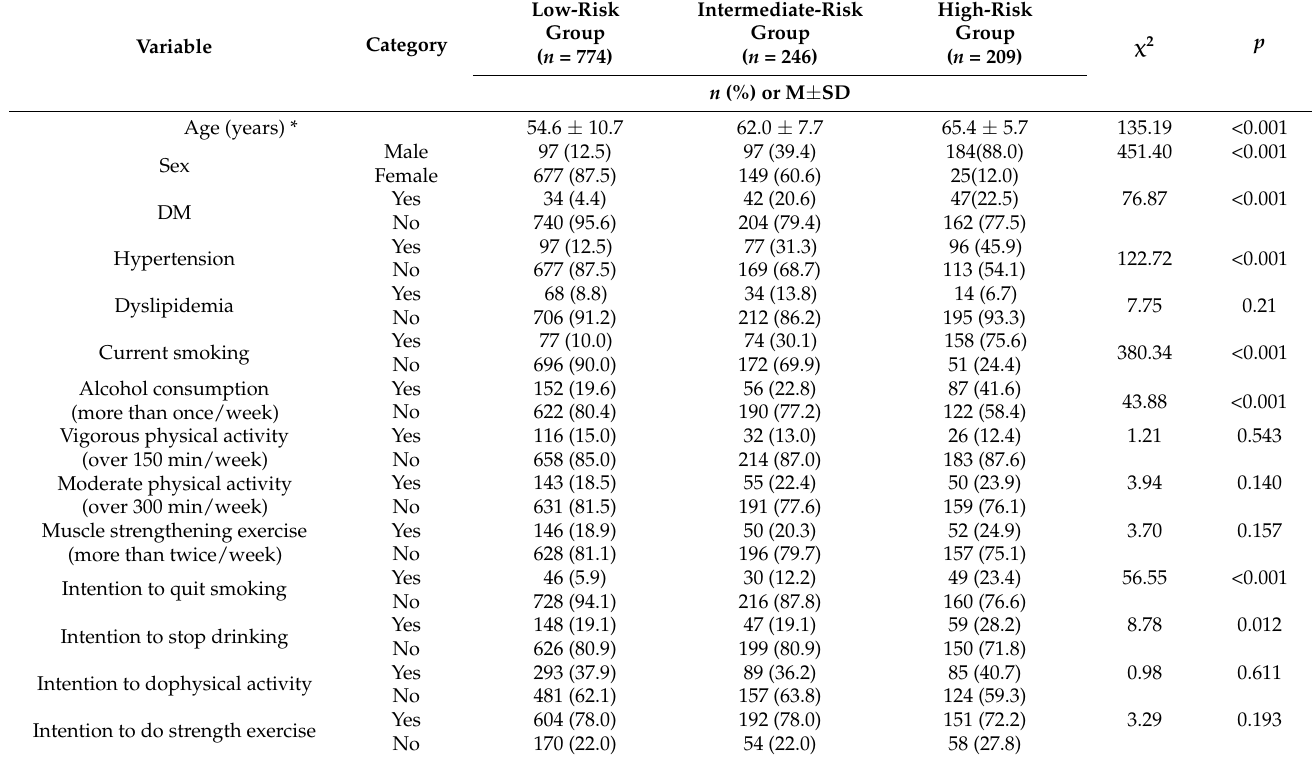
Table 1. Differences in general characteristics and intention to modify lifestyle according to FRS ( N = 1229).